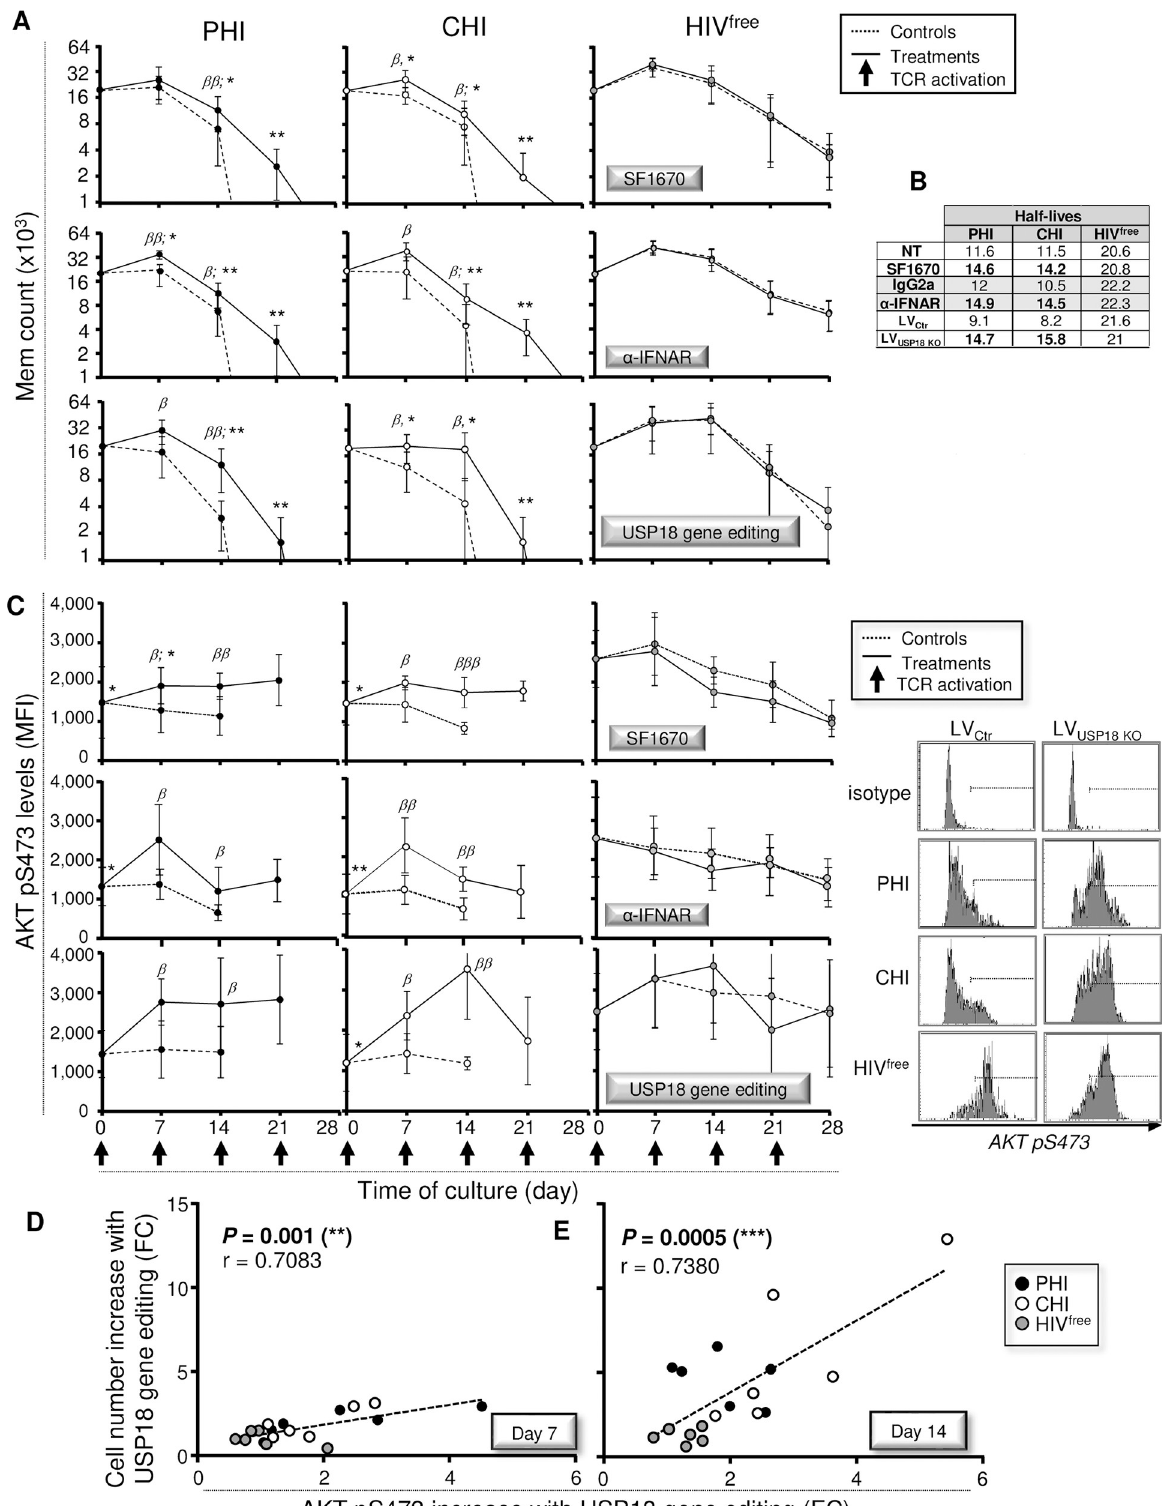
Fig 5. Targeting USP18 in PHI and CHI results in improved Mem maintenance in an AKT-dependent manner. ( A ) Mem counts from PHI, CHI, and HIV free following TcR activation every 7 days for 28 days with or without SF1670 (top), α -IFNAR or its respective isotype control